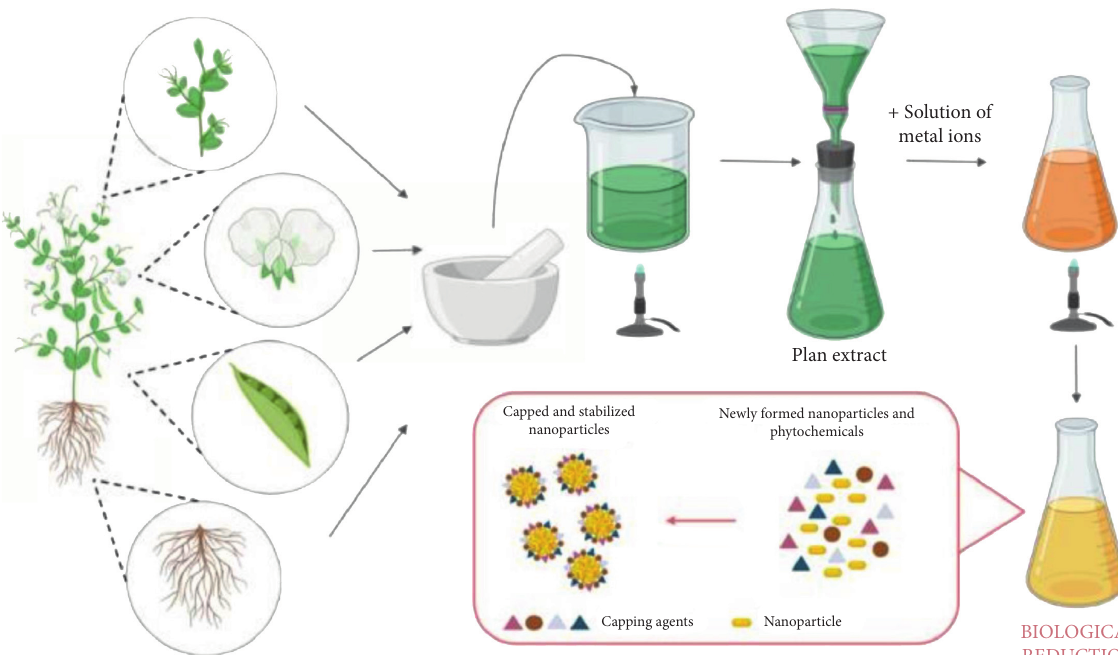
Figure 3: The typical process of plant-mediated green synthesis of metal nanoparticles